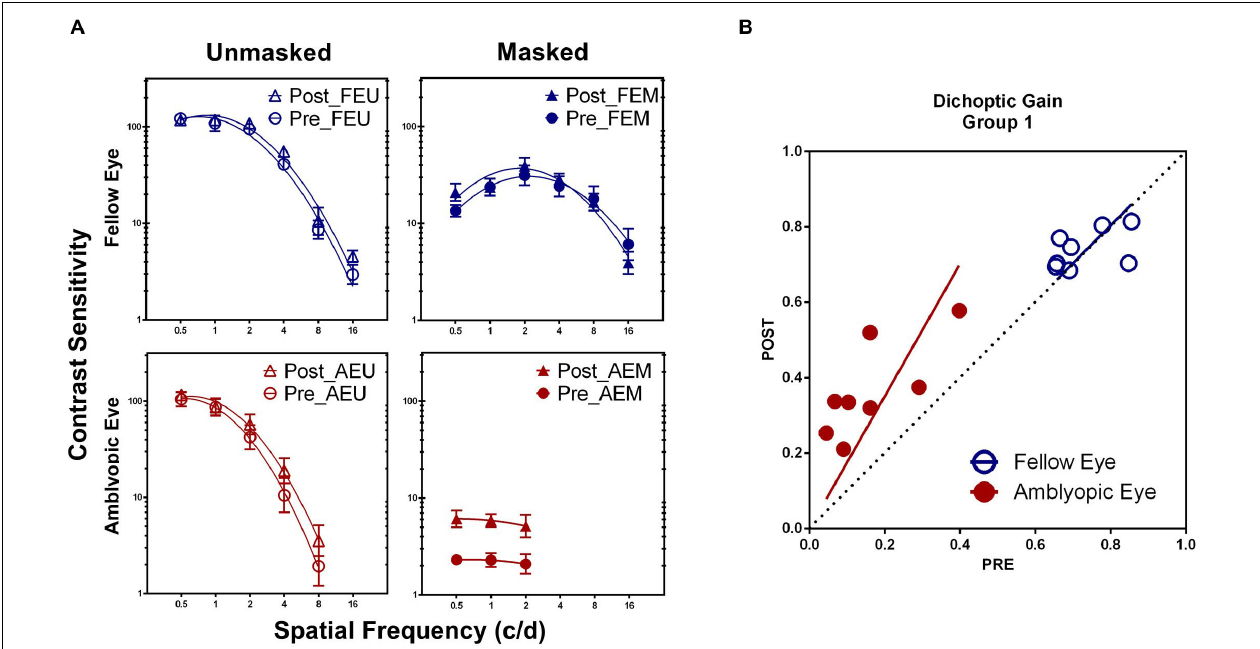
FIGURE 3 | (A) Pre- and post-training contrast sensitivity functions (CSFs) under different conditions in Group 1. (B) Dichoptic gains for the two eyes before HNC training ( x -axis) are plotted against those after training ( y -axis). The diagonal unity line represents unchanged dichoptic gain between pre- and post-training